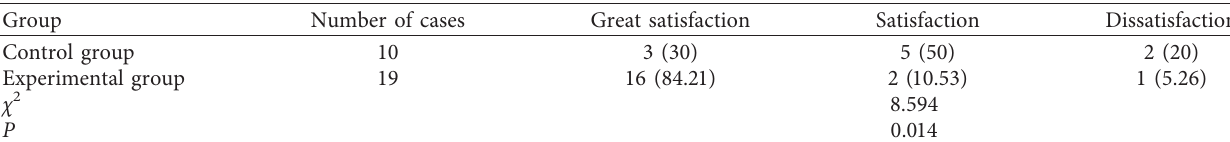
Table 6: Comparison of